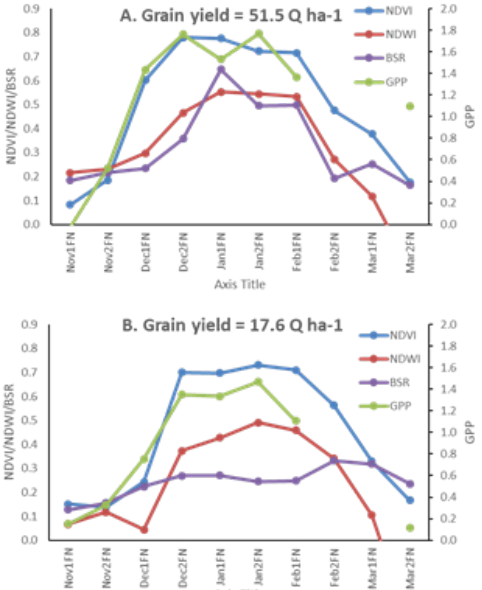
Fig 4. Temporal profile of all four indices for A) High grain yield and B) low grain yield location